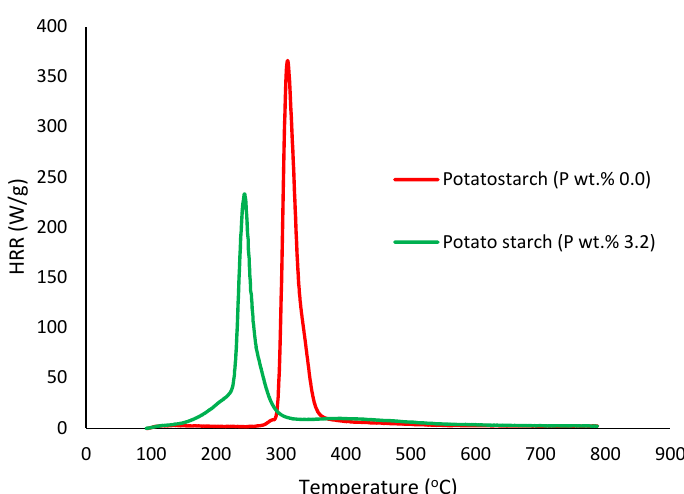
Figure 9. Plot of heat release rate (HRR) (W/g) versus temperature (°C) for modified and unmodified versions of dextran.